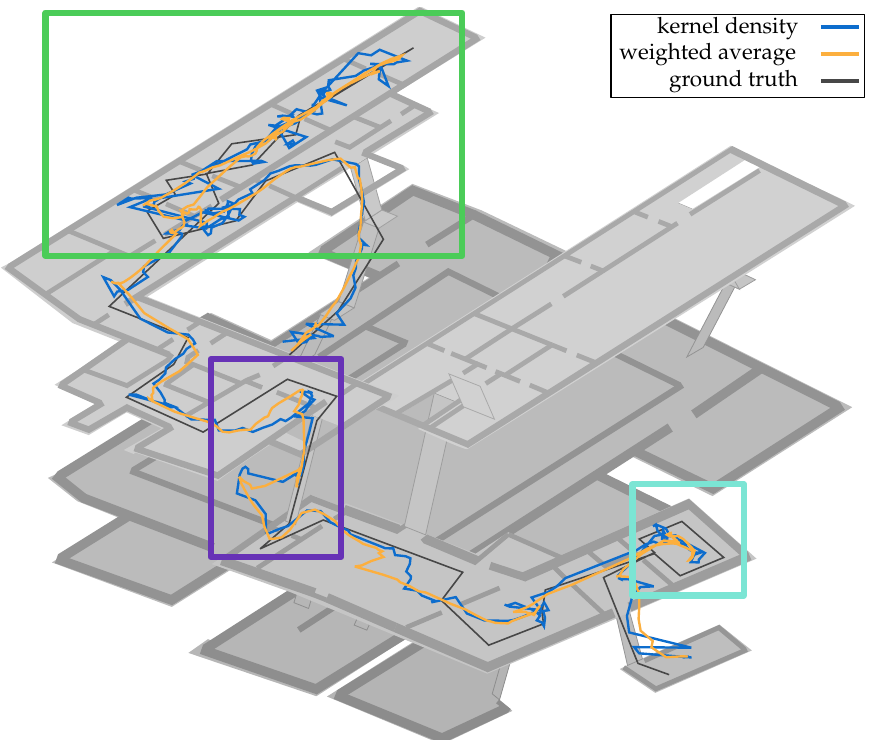
Figure 12. Estimation results of walk 2 using the KDE method (blue) and the weighted-average (orange). While the latter provides a more smooth representation of the estimated locations, the former provides a better idea of the quality of the underlying processes. In order to keep a better overview, the top level of the last floor was hidden. The colored rectangles mark interesting areas. Within the green rectangle, the above mentioned differences between the two methods are clearly visible. The purple rectangle displays a situation in which a sample impoverishment was successfully resolved. The teal rectangle marks an area were both methods do not provide sufficient